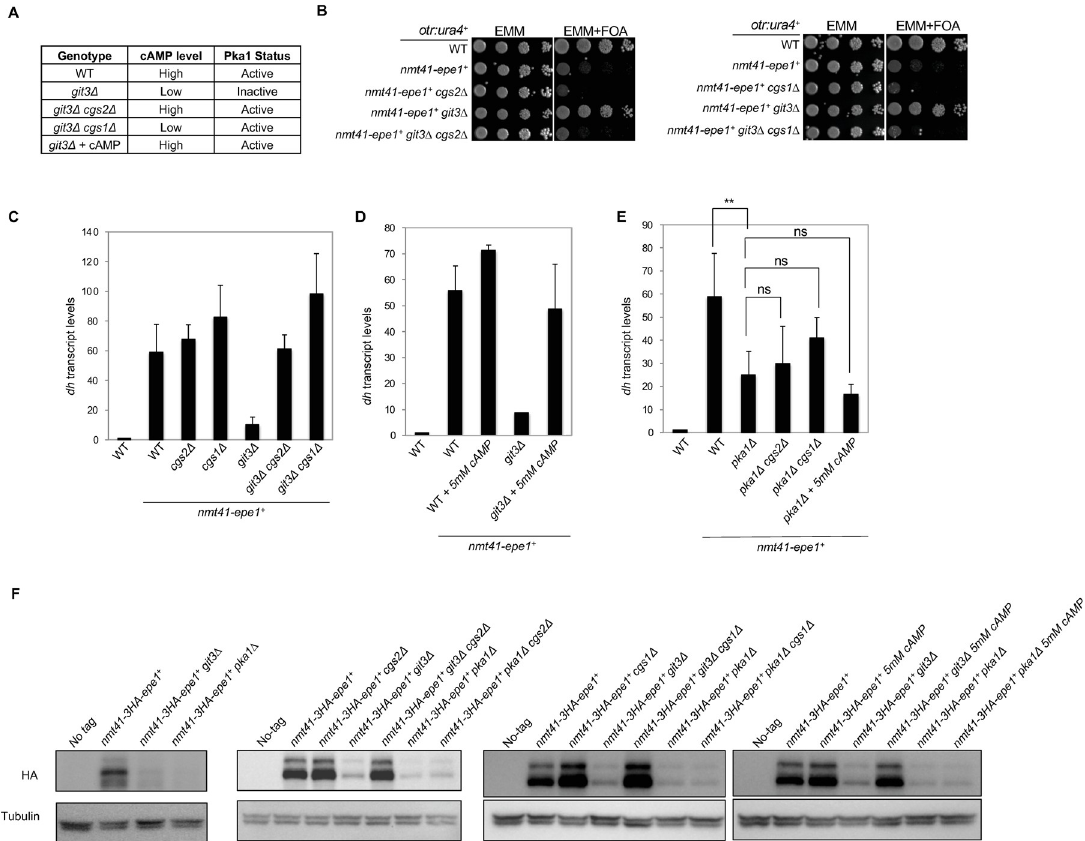
Fig 2. High levels of cAMP and an active Pka1 are required for Epe1 function. (A) Summary of effects of git3 Δ , cgs2 Δ , cgs1 Δ , and exogenous cAMP on cellular cAMP levels and the activity of Pka1. (B) Ten-fold serial dilution analyses of indicated yeast strains grown on indicated media to measure the expression of the otr :: ura4 + reporter gene. (C-E) RT-qPCR analyses of pericentric dh transcript, normalized to act1 + . Error bars represent SD, n � 2. One-way ANOVA was performed comparing each strain to nmt41-epe1 + pka1 Δ . (F) Western blot analyses to measure the levels of 3HA-tagged Epe1 under the control of nmt41 promoter and the levels of tubulin.